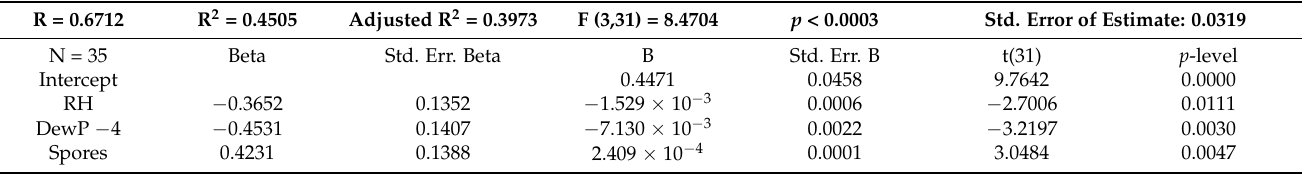
Table 5. Multiple lineal regression parameters of the developed prediction model for airborne protein concentrations.